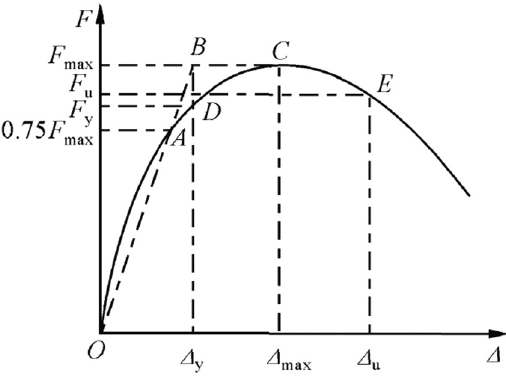
Figure 14: Schematic diagram of yield point of PAPK method [ 37 ] .